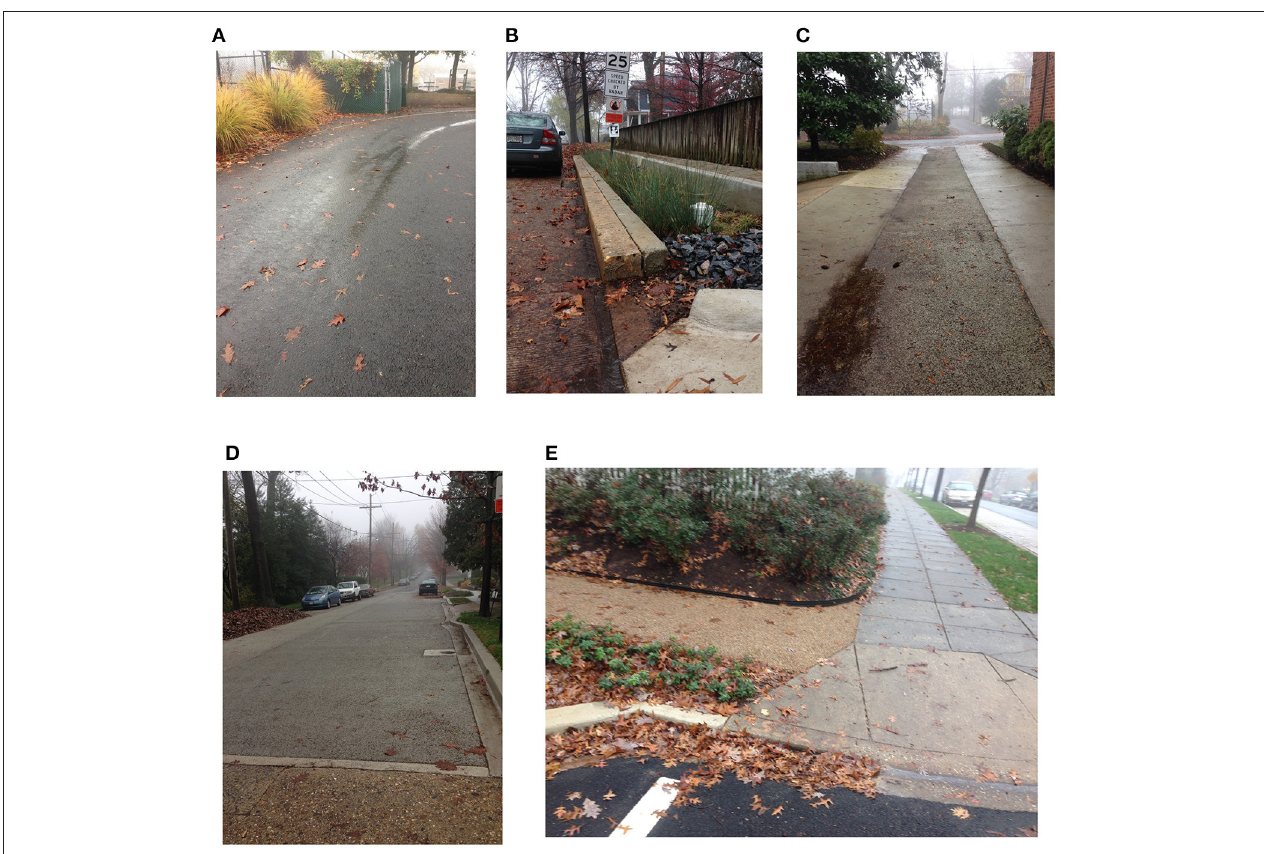
FIGURE 3 | Site Photographs of BMPs treating the sewershed’s public ROWs. (A) Permeable asphalt: surface runoff is visible, indicating lower than expected infiltration performance. (B) Bioswale with a flush curb cut extending beyond the ROW into adjacent grass strip. (C) Permeable concrete installed in the center of a reverse crowned alley. (D) Permeable concrete spanning the full width of the ROW. (E) Foreground shows permeable rubber sidewalk adjacent to bioswale. Permeable pavers in parking lane are visible in the